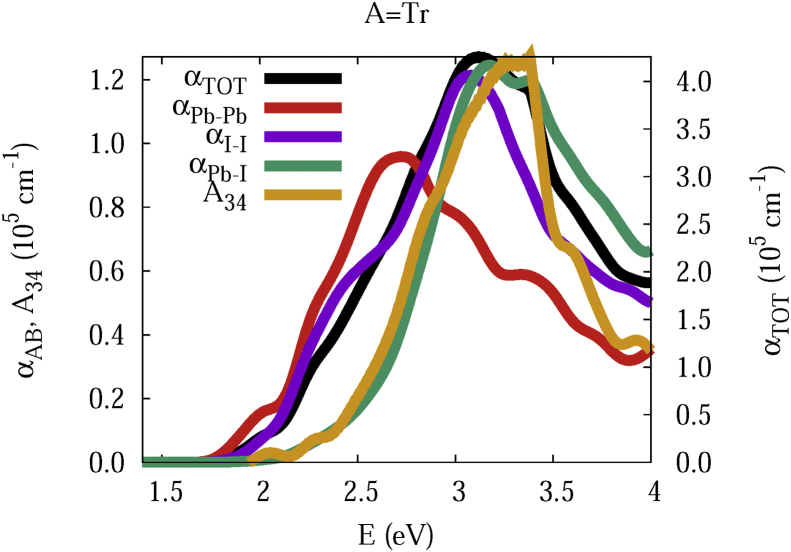
Same legend as that in Fig. 1, but for A = Tr.